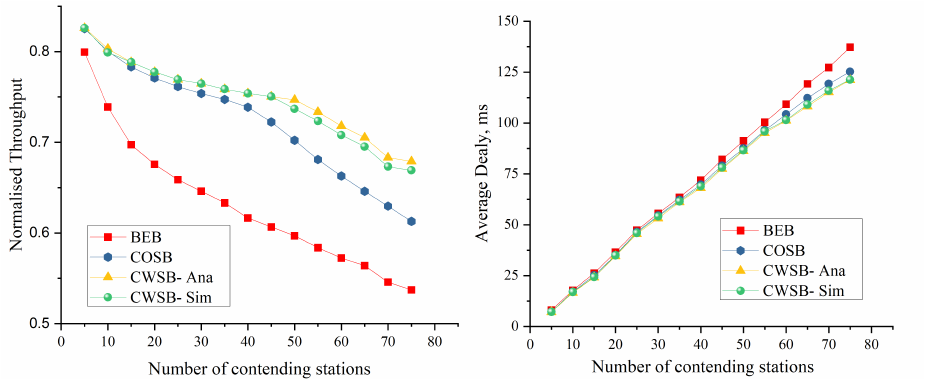
Figure 9. Calculated normalised throughput and average delay under a saturated traffic